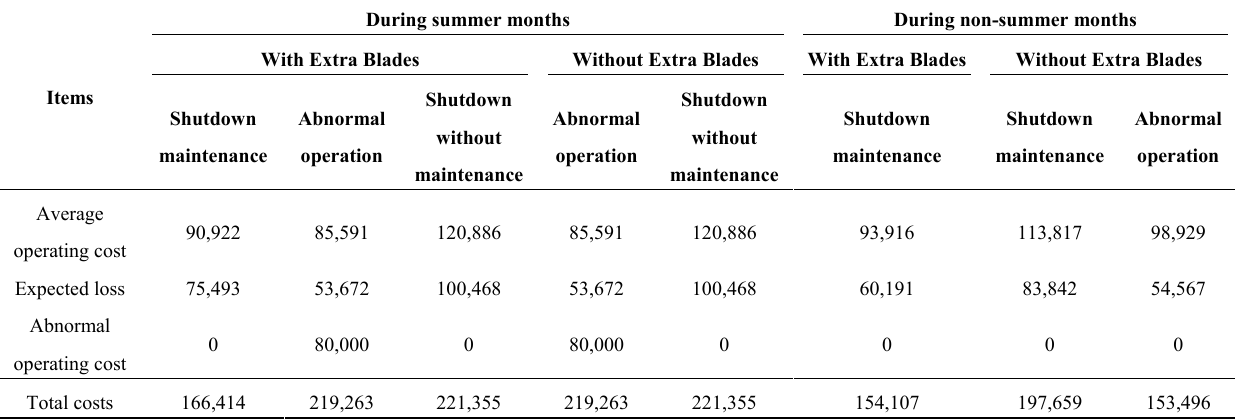
Table 13. Total costs of operating the TG-2 steam turbine when there are replacement blades. Unit: